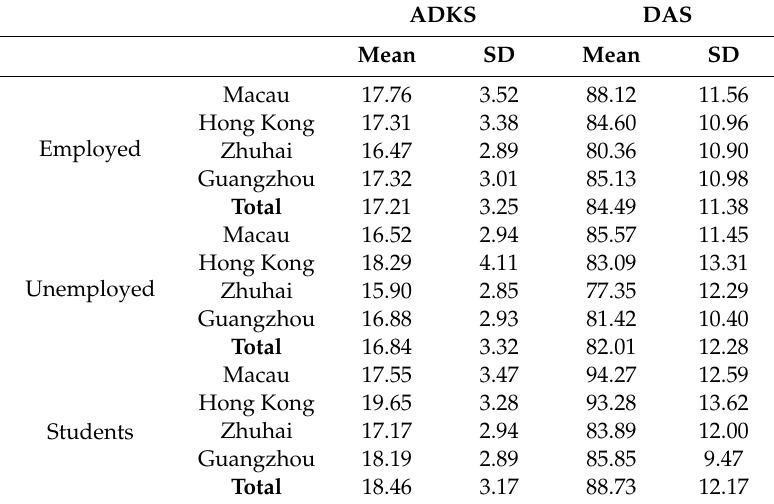
Table A3. Comparison of the ADKS and DAS scores of students, and the employed and unemployed